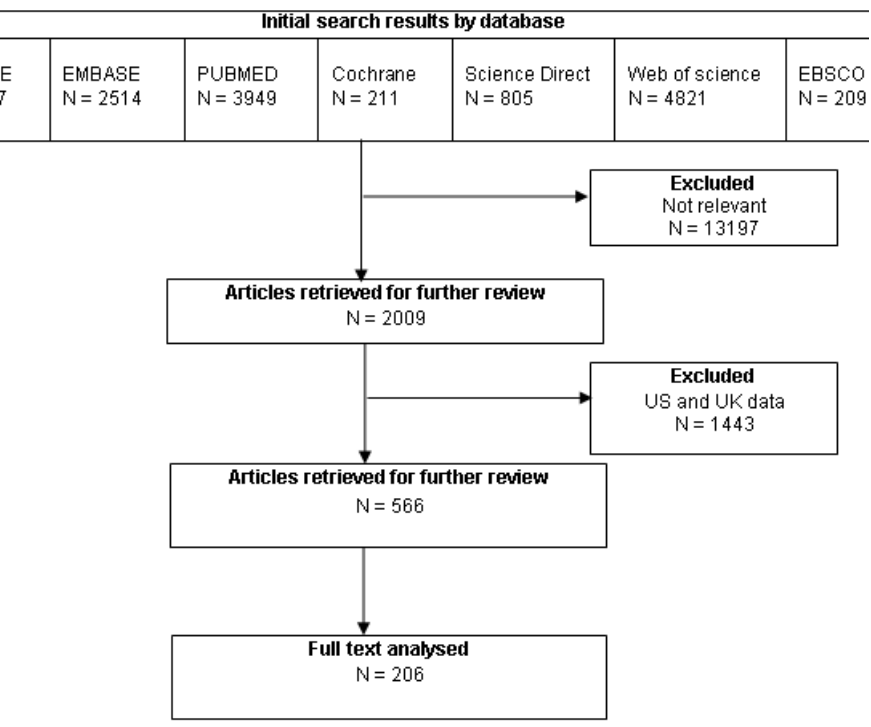
Figure 1. QUOROM flow